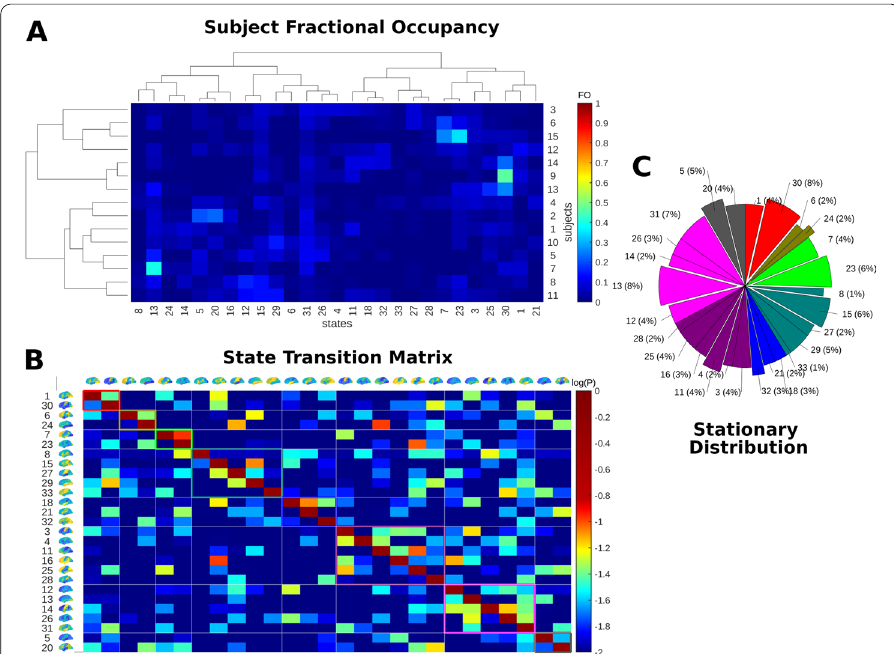
Fig. 4 A summary of the subject state network dynamics. A Clustergram showing the relationships in Fractional Occupancy (FO), the proportion of time spent in a state clustered by subjects (vertically) and by states (horizontally). B The log of the state transition matrix P is shown, where states have been grouped along the diagonal, according to their community membership. C Pie chart showing the state occupancy at equilibrium (the probability of finding a subject in a state in the limit as time goes to infinity). Wedges in this pie chart are the individual hub states in each community according to the community z -score. These